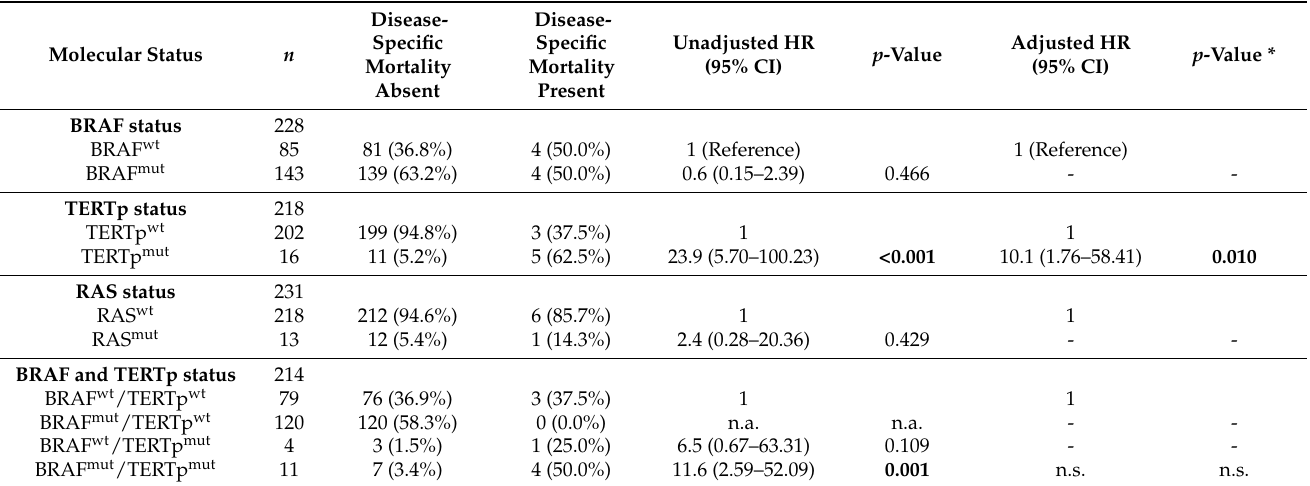
Table 5. Analysis of molecular status in the risk of disease-specific